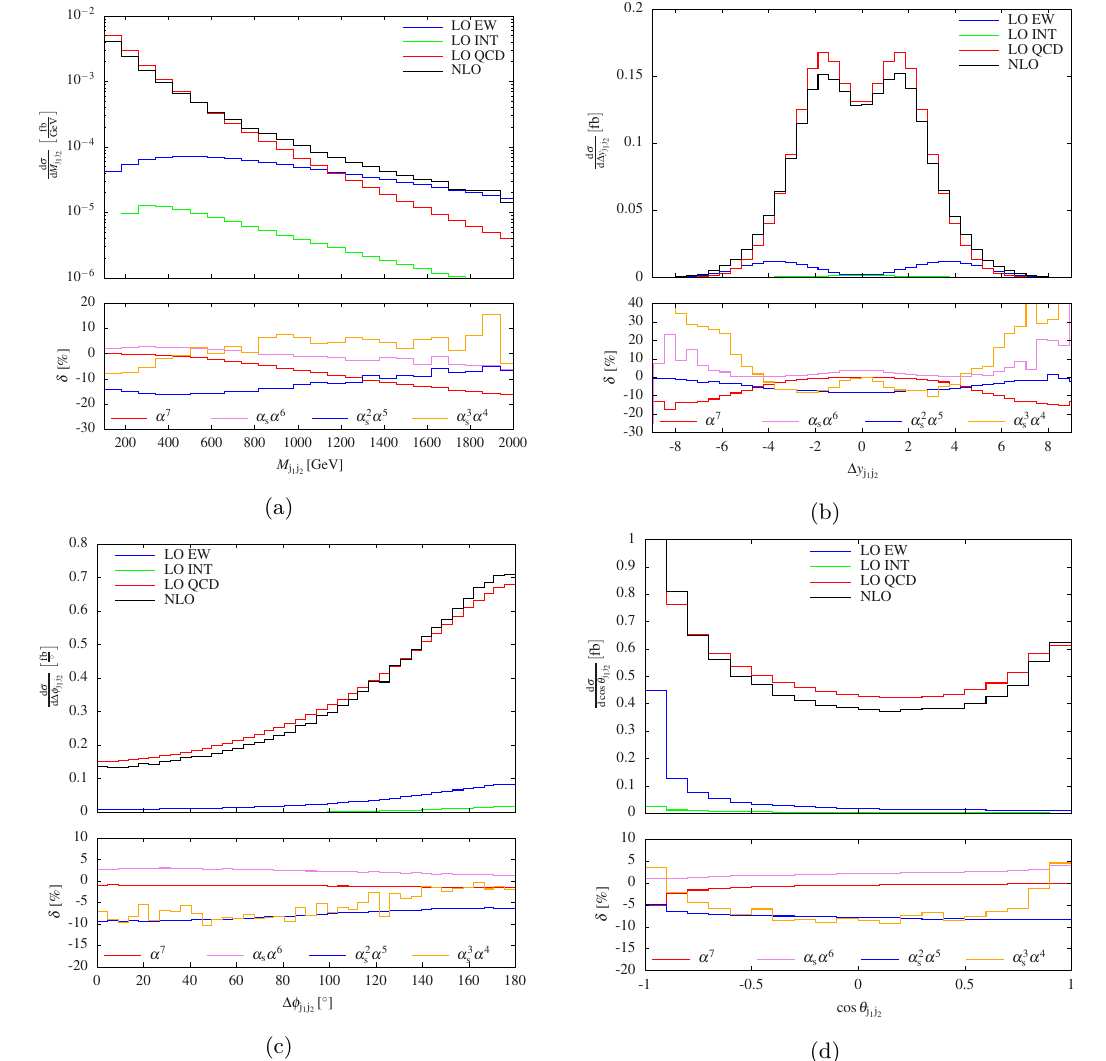
Figure 4 . Separate contributions of LO and NLO. The upper panels show absolute predictions (cid:0) (cid:1) (cid:0) (cid:1) (cid:0) (cid:1) of orders O α 6 (LO EW), O α s α 5 (LO INT), O α 2 α 4 (LO QCD) and the complete NLO s (cid:0) (cid:1) (cid:0) (cid:1) (cid:0) (cid:1) prediction. The lower panels display the contributions of orders O α 7 , O α s α 6 , O α 2 α 5 , and s (cid:0) (cid:1) O α 3 α 4 relative to the complete LO predictions. The observables read as follows: invariant mass s of the two tagging jets (top left), rapidity separation of the two tagging jets (top right), azimuthal angle between the two tagging jets (bottom left), and cosine of the angle between the two tagging jets (bottom